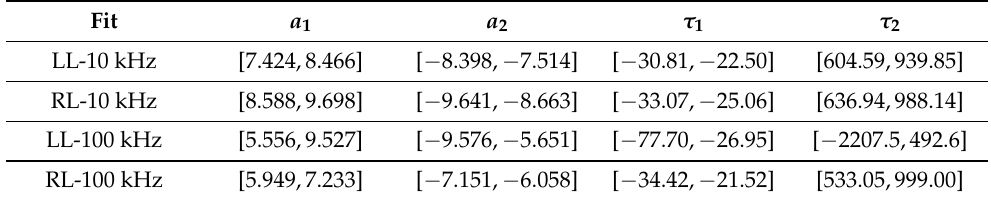
Table 4. 95% Confidence intervals of coefficients from the fitting of median segmental leg resistances to the two-term exponential